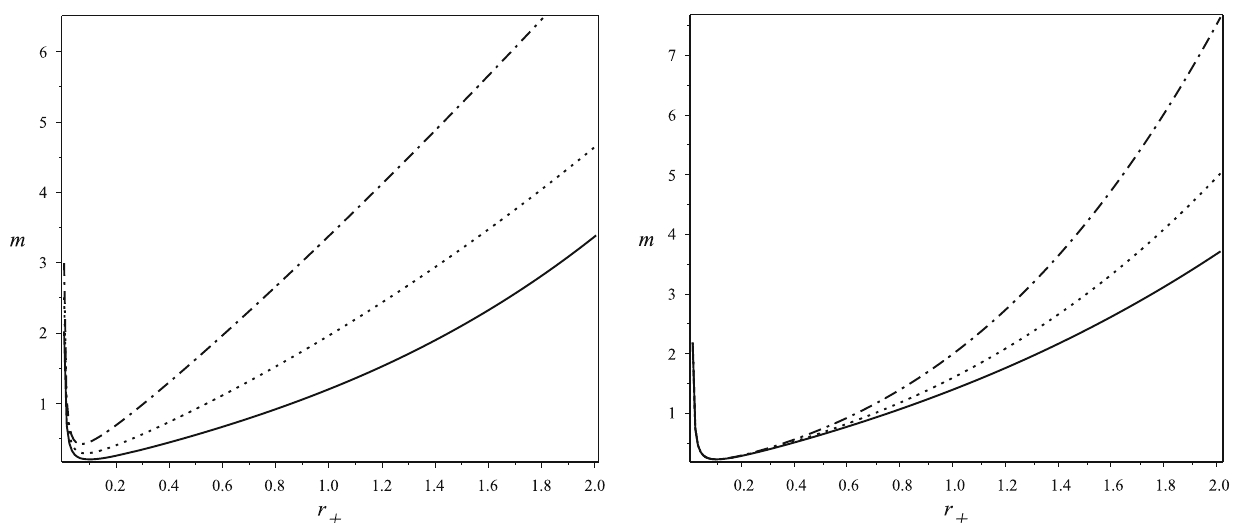
Fig. 1 Mass parameter m as a function of horizon radius r + for sev- eral values of parameter α (the left graph) or cosmological constant (cid:2) (the right one). Namely, for the left graph the correspondence is the following: the solid curve corresponds to α = 0 . 1, the dotted curve corresponds to α = 0 . 5 and the dash-dotted one to α = 0 . 7, for all the